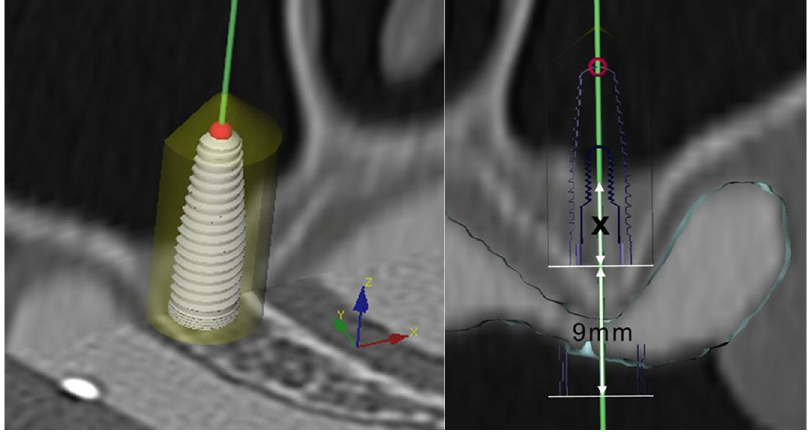
Figure 1. 3D planning procedure for flapless transcrestal sinus floor elevation